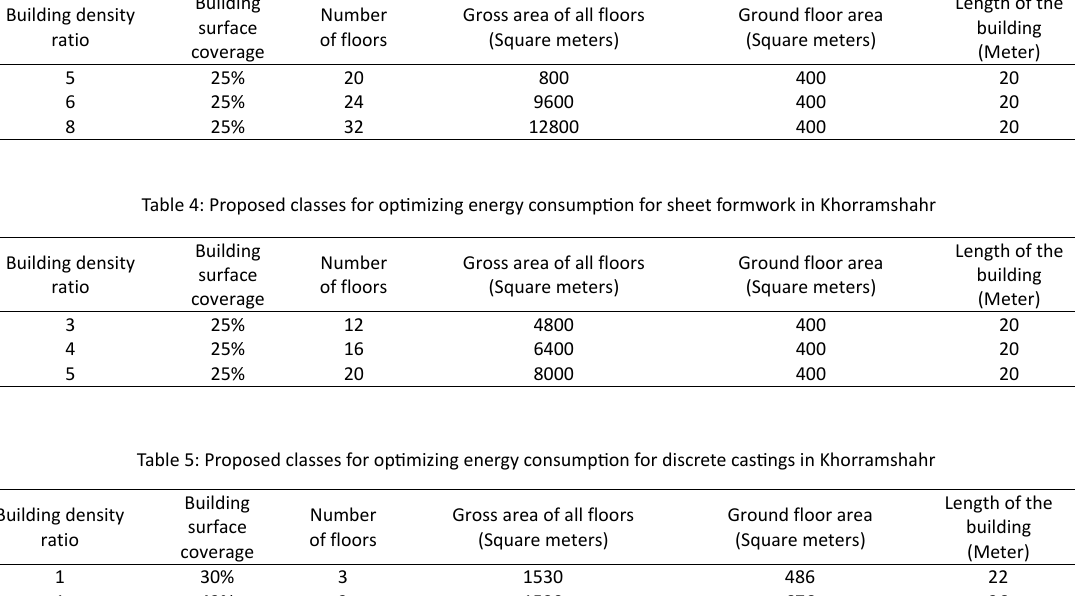
Table 3: Proposed classes for optimizing energy consumption for high‐rise building castings in Khorramshahr Building density ratio